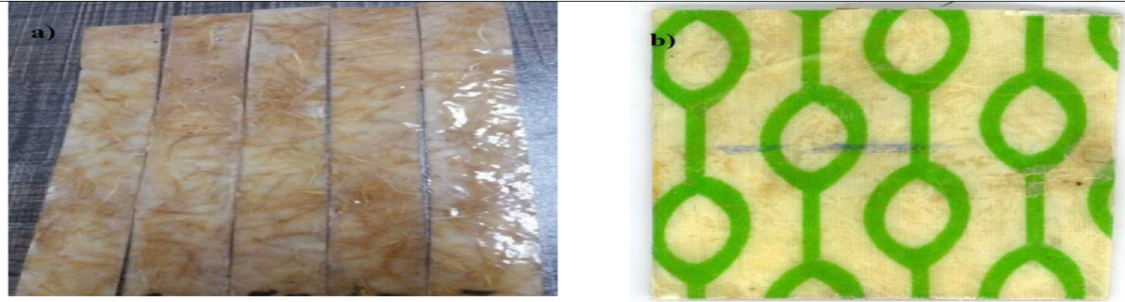
Fig. 2: Original photographs of; a) Bagasse fiber reinforced composite, b) Bagasse-cotton fabric reinforced composite